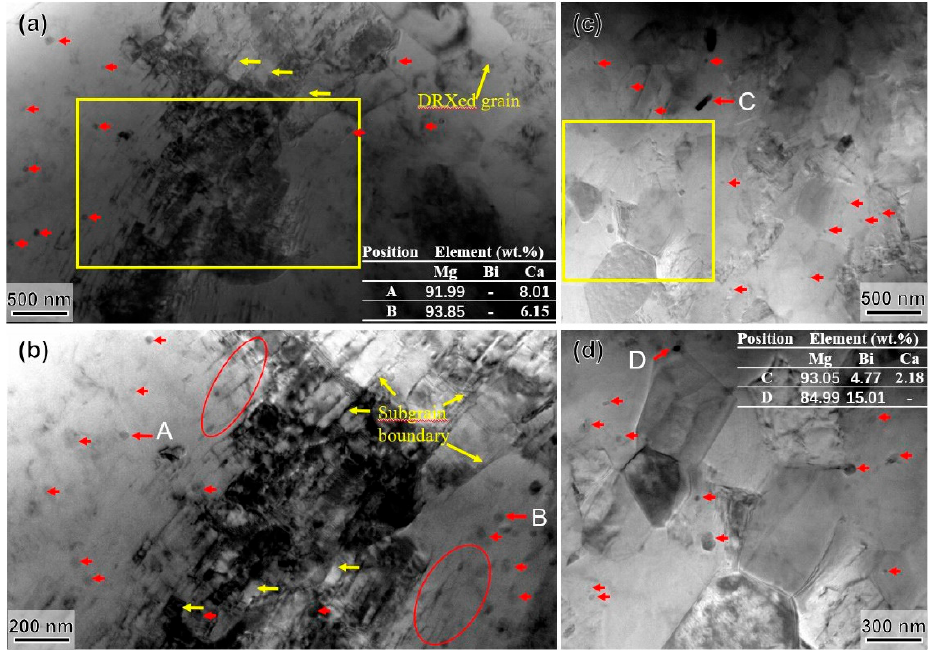
Figure 4. TEM bright field images of the ( a , b ) elongated region and ( c , d ) DRXed region of the as-extruded BX11 alloy.